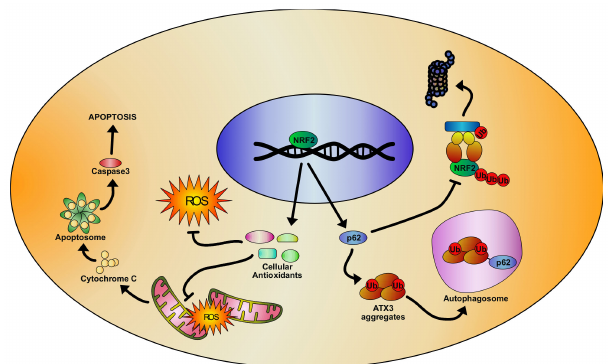
Figure 3. Representative model of the NRF2 signaling pathway activation in spinocerebellar ataxia